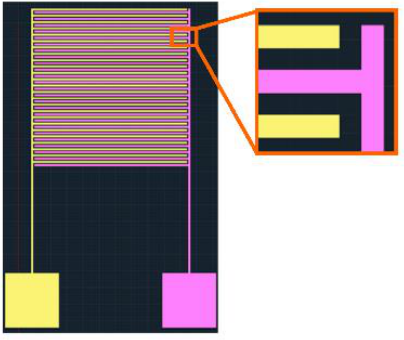
Figure 1. The configuration of the IDμE sensor.